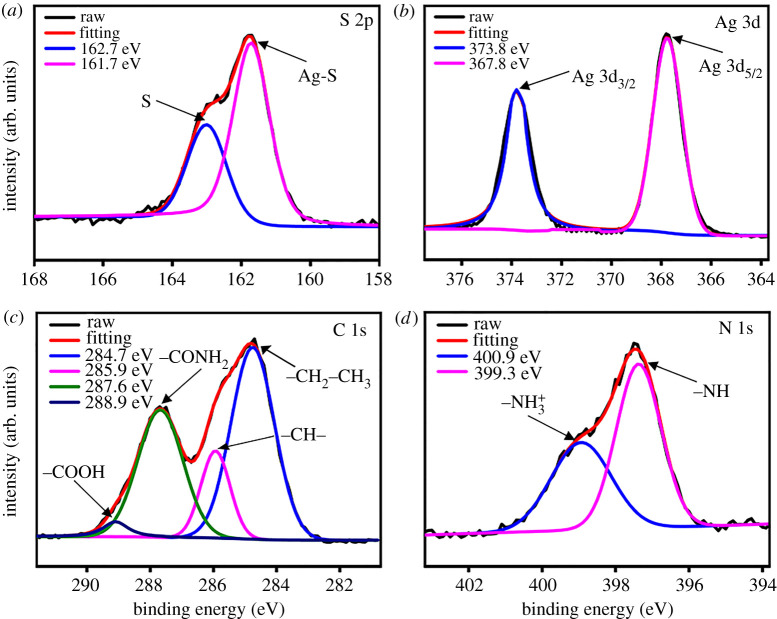
The high-resolution XPS spectra of Ag2S CDs. (a) S 2p, (b) Ag 3d, (c) C 1s and (d) N 1s.